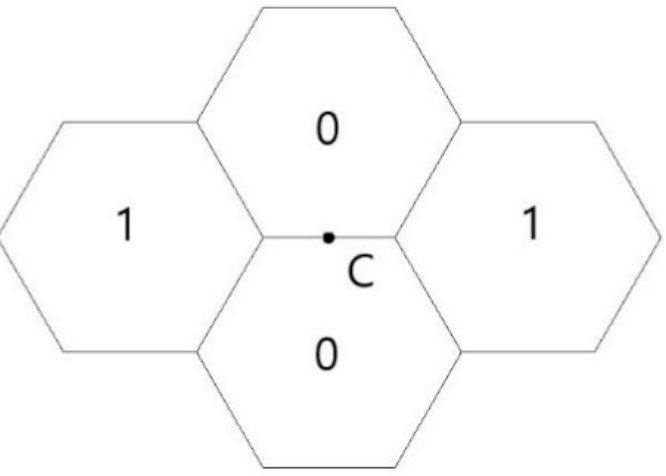
Figure 2. Center of location area ( N = 4).